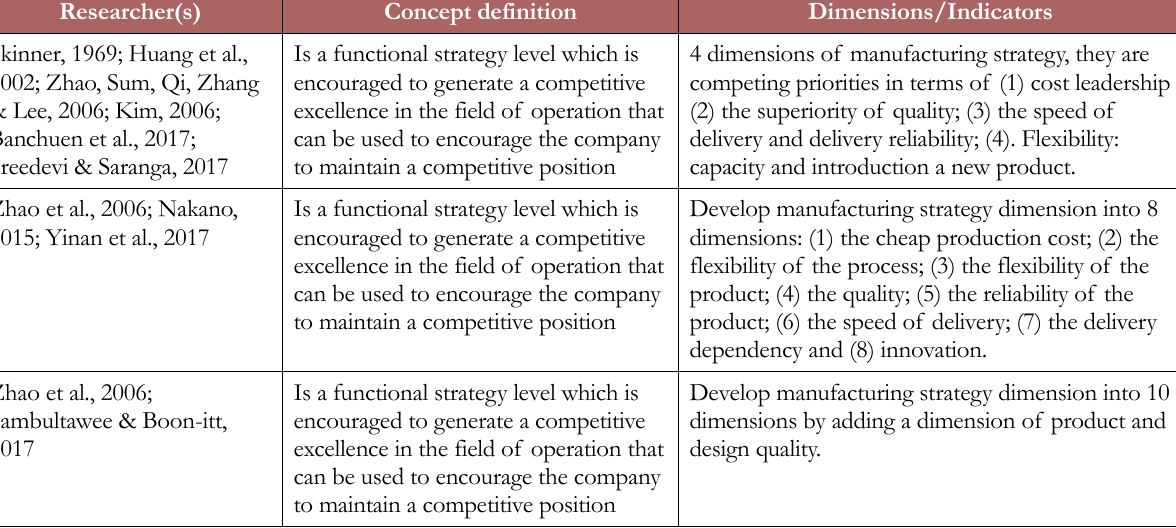
Table 2. Various opinions about the conception of manufacturing